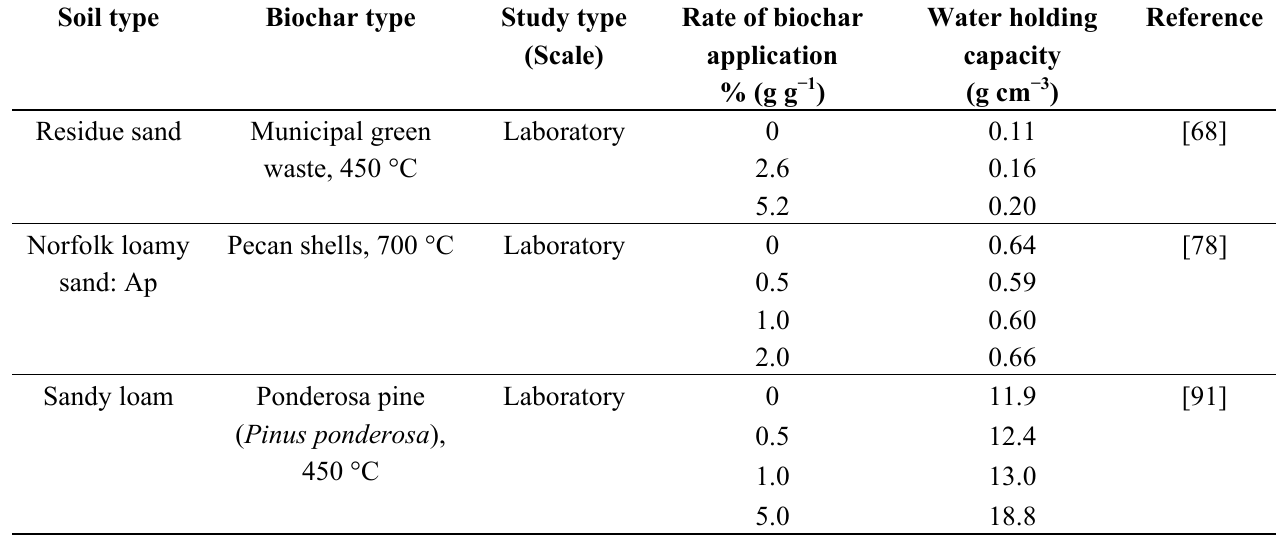
Table 4. Impact of biochar on water holding